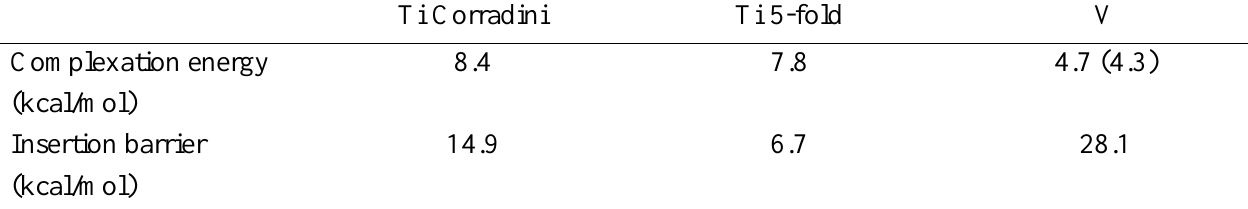
Table 1. Complexation energies and activation barrier for the insertion of an ethylene molecule in the Ti and V active catalytic sites, as obtained by the simulations. The complexation energy in parentheses in the V column refers to the V site that is destabilized, as explained in the